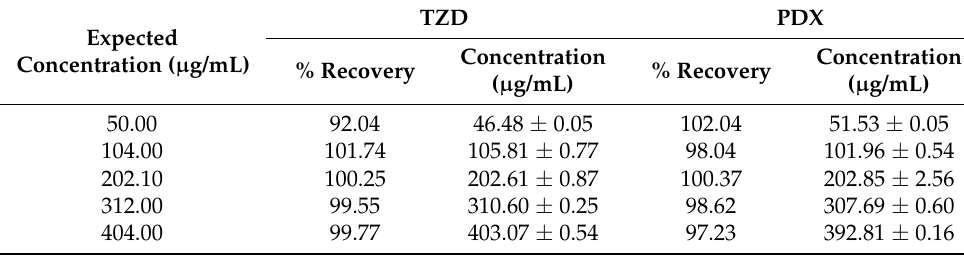
Table 1. Accuracy results obtained for TZD and PDX determined at 50, 100, 200, 300, and 400 µ g/mL. Expected Concentration